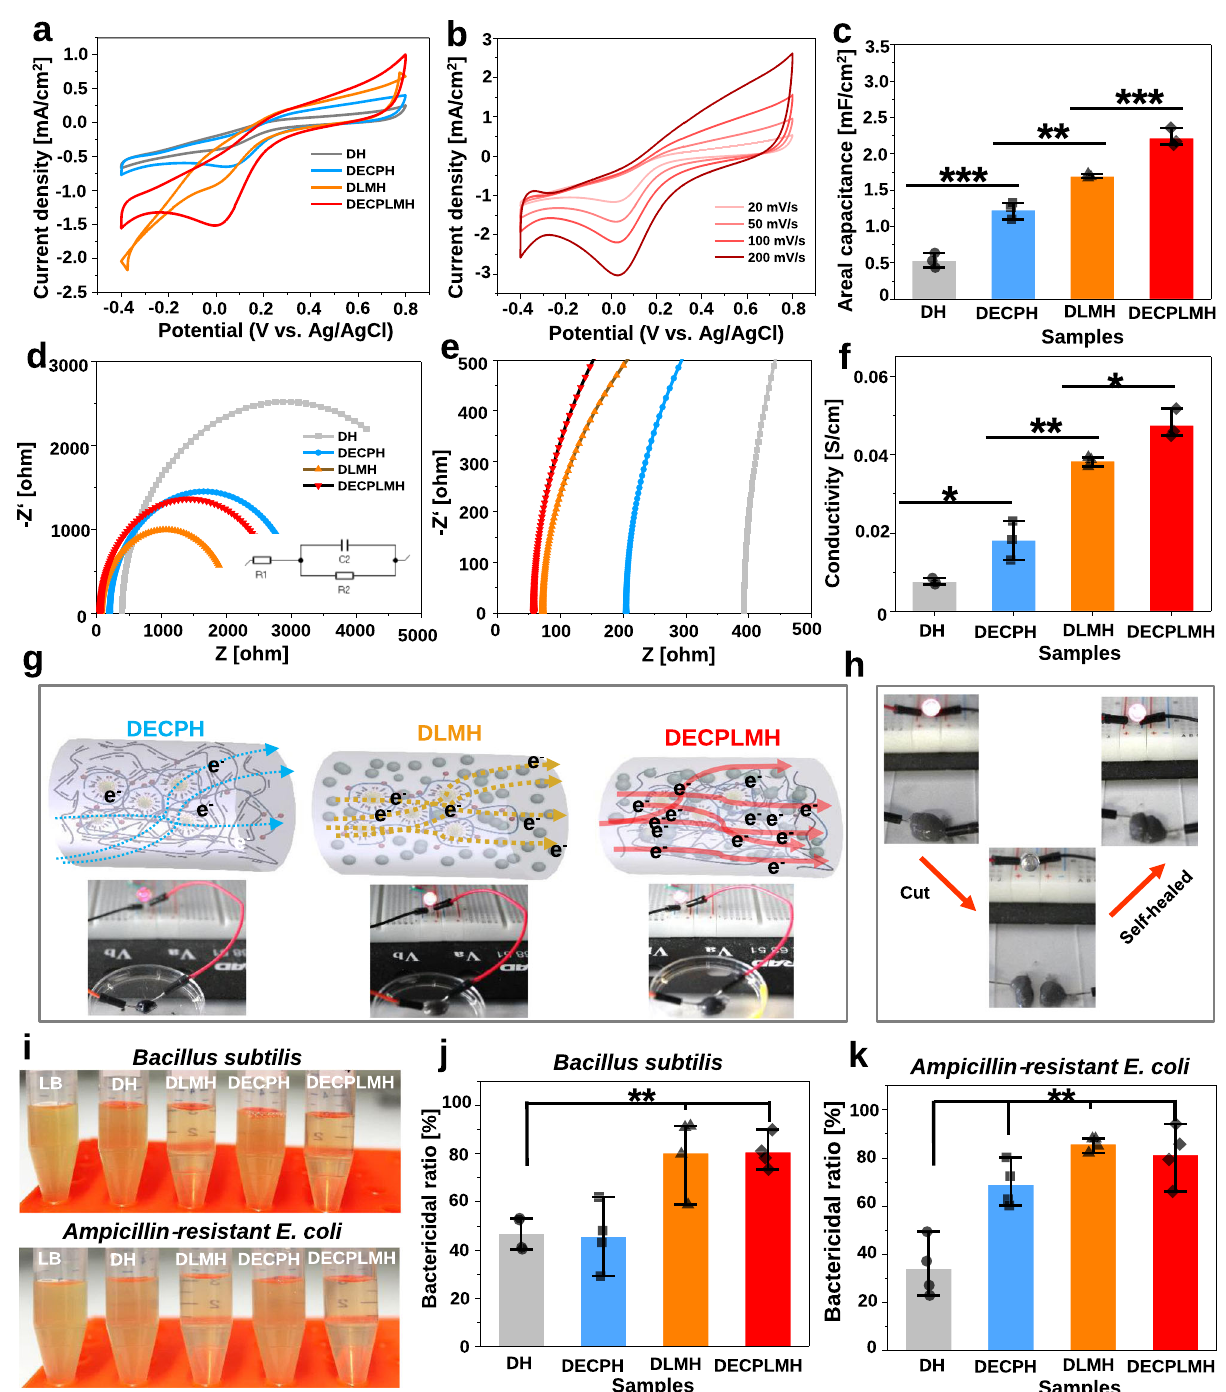
our results show that the DECPLMH hydrogel possesses good cytocompatibility when exposed to various types of cells (C2C12, MSCs, and L929) in long-term (21 days) 2D (cell-material contacts) and 3D